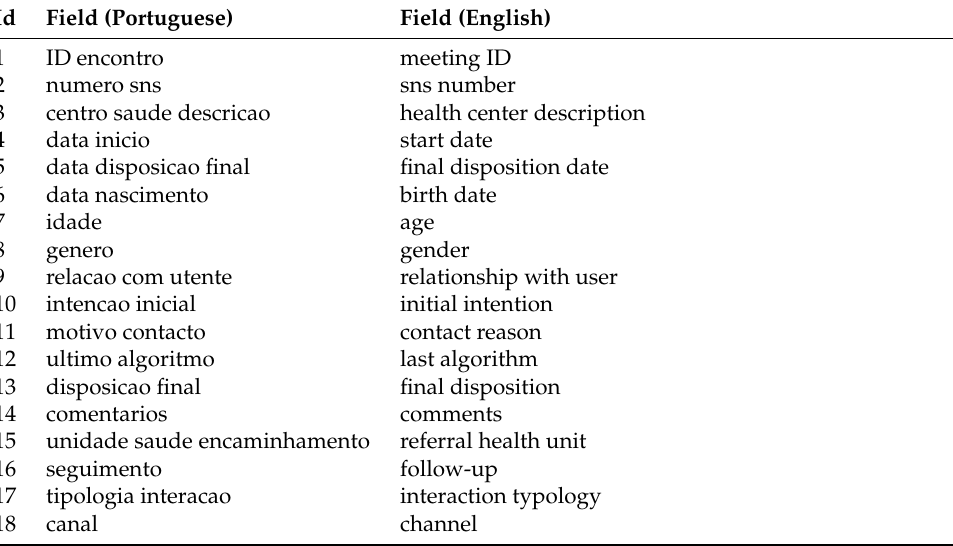
Table 1. The 18 fields recorded in the original dataset. The fields are listed in the original language Portuguese and English.